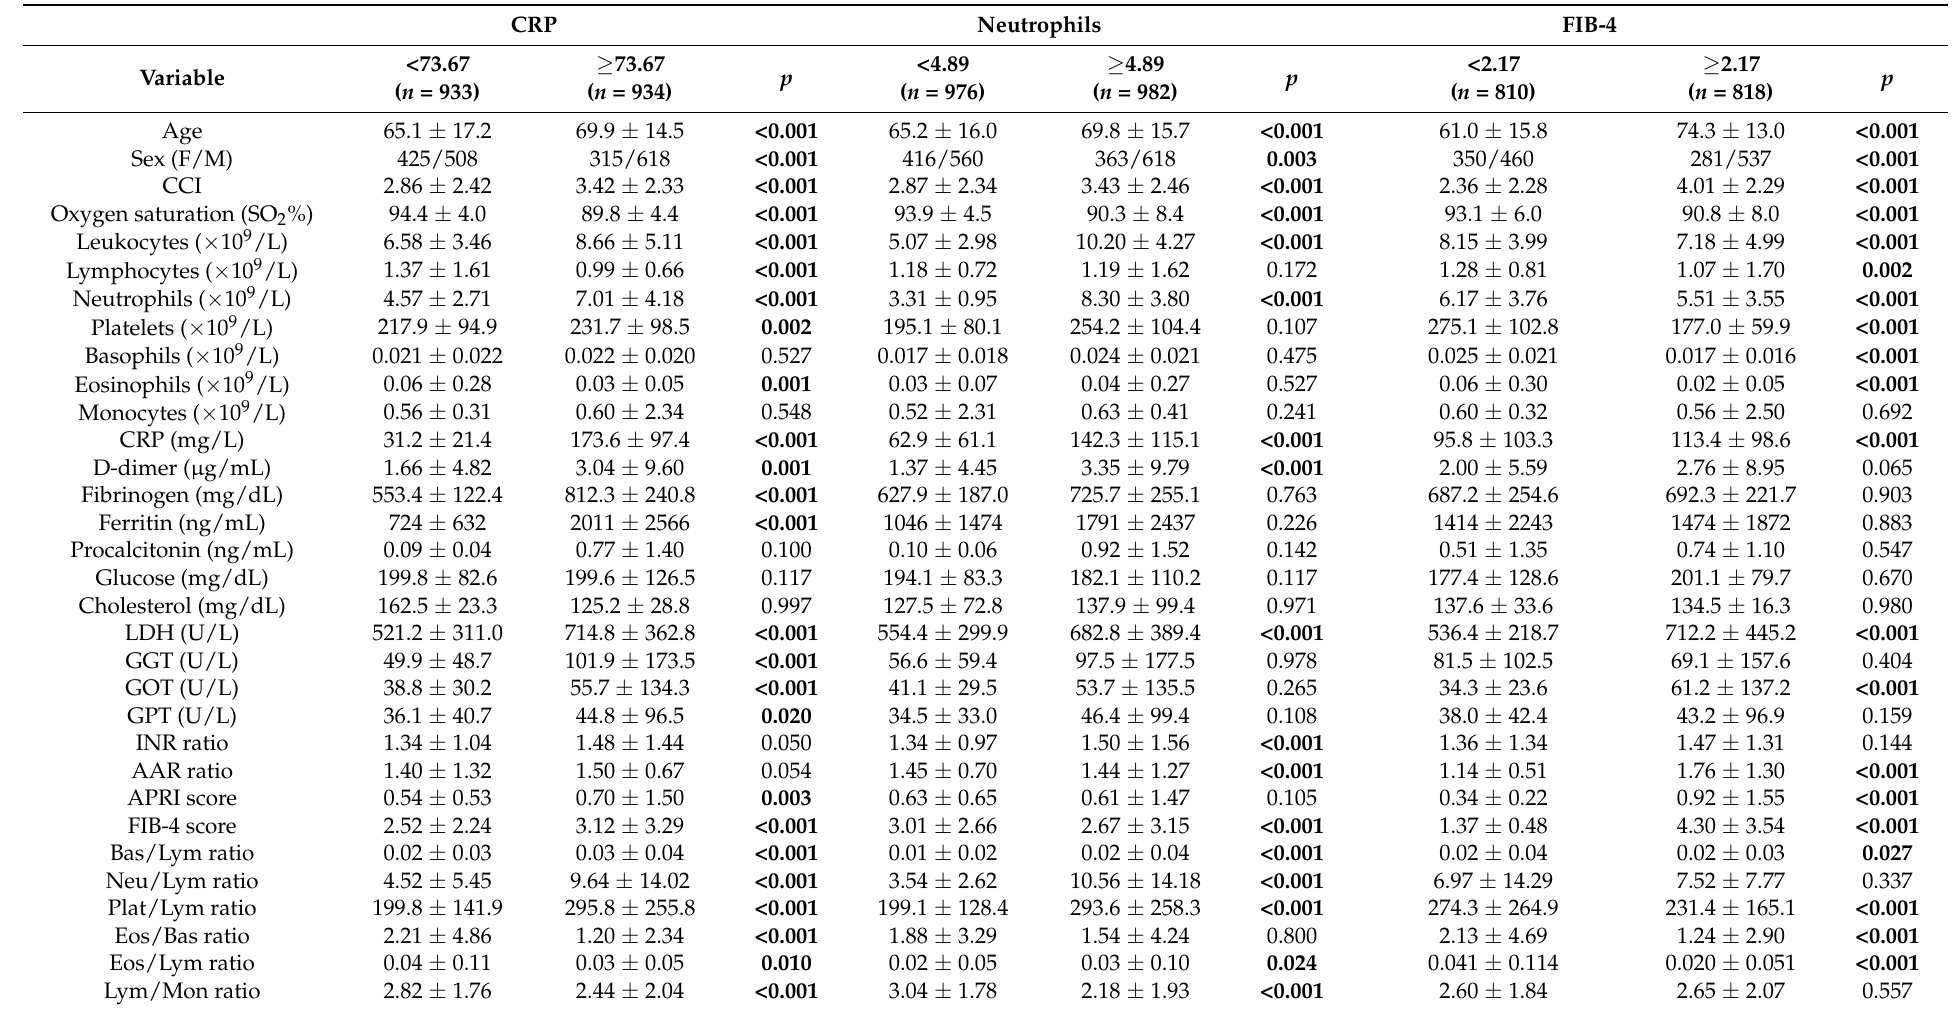
Table 2. Clinical and phenotypical characteristics of COVID-19 patients based on median values of inflammatory and liver